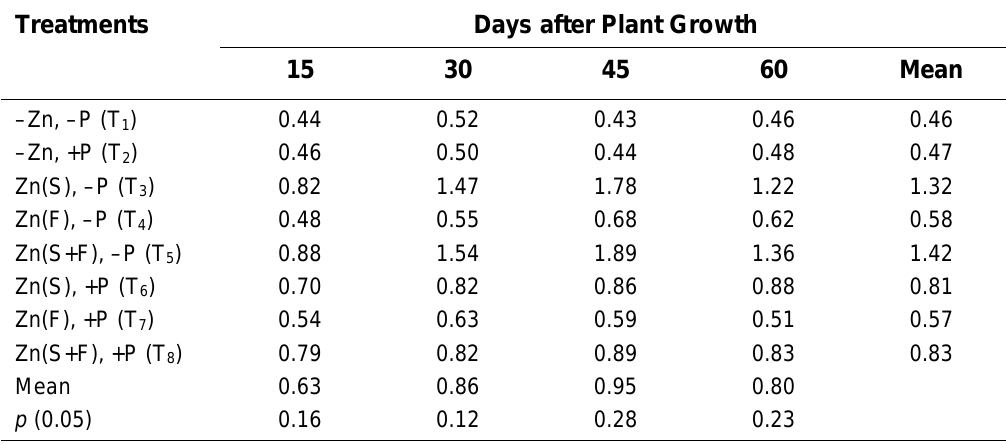
Interaction Effect Between P and Zn on the Changes in Zn Content (mg/kg) in Soil